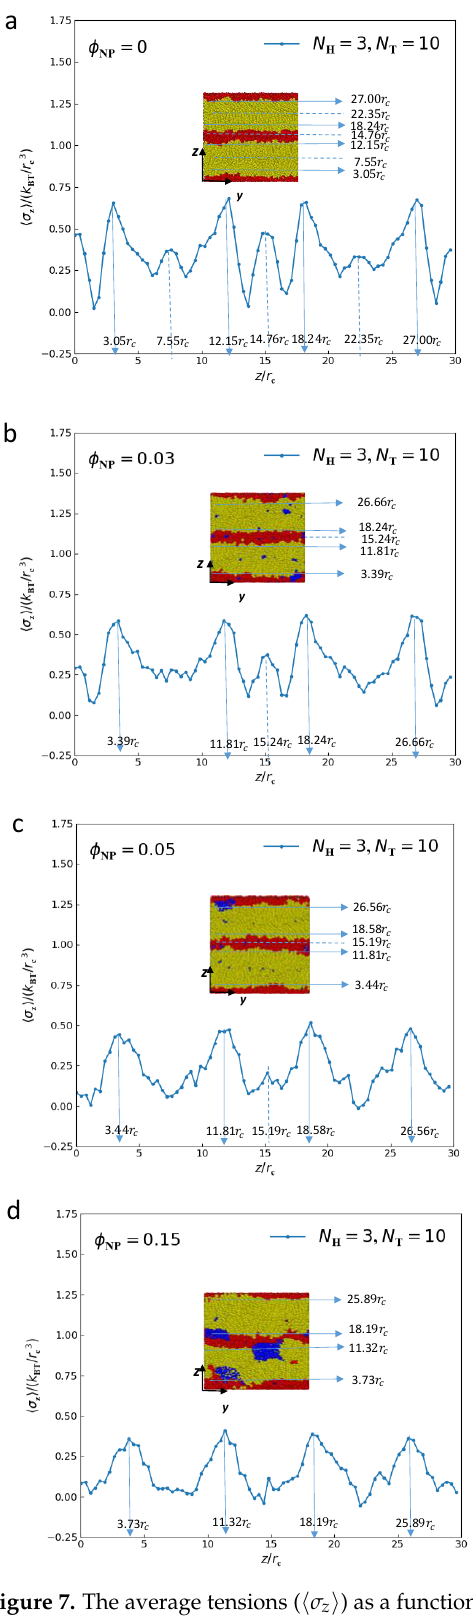
Figure 7. The average tensions ( (cid:104) σ z (cid:105) ) as a function of distance along the z -axis for lamellar structures with ( a ) φ NP = 0, ( b ) φ NP = 0.03, ( c ) φ NP = 0.05 and ( d ) φ NP =